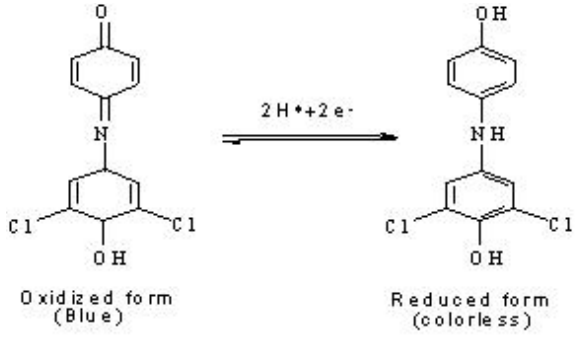
O 2 − on reduction of 2 5